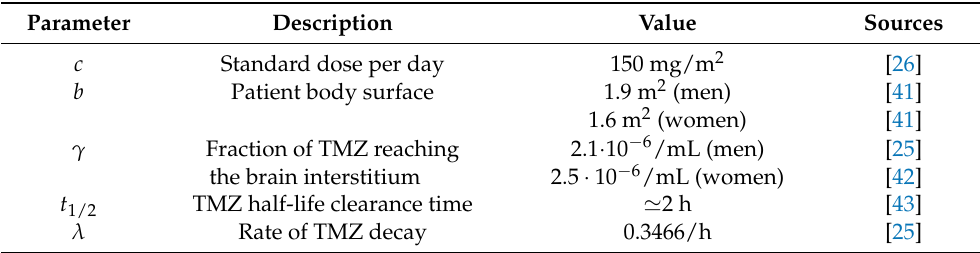
Table 2. Parameters describing TMZ concentration in brain tumor tissue. Parameter Description Value